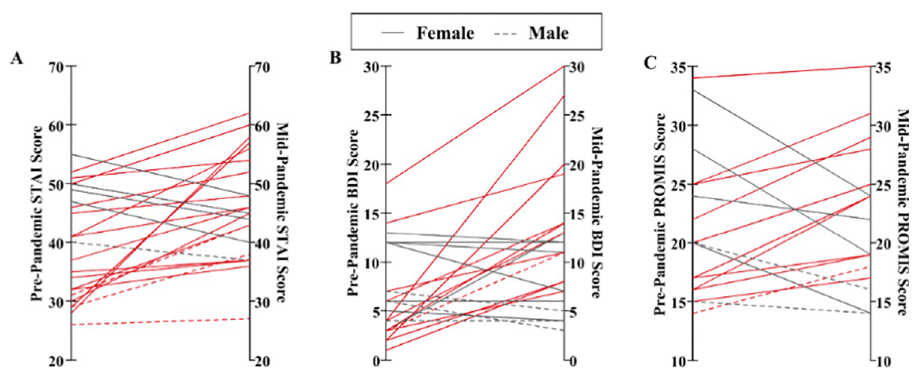
Fig 2. State Trait Anxiety Inventory (STAI) and BDI scores differ pre- and mid-pandemic. A) . STAI scores increased from pre- to mid-pandemic, (t (21) = -3.077, p = 0.006), with individuals being 4 times more likely to be anxious during mid-pandemic than during pre-pandemic (OR = 4.08, 95% CI: 1.11–15.02, Z = 2.12, p = 0.034). B) BDI scores increased from pre- to mid-pandemic (Z = -2.702, p = 0.007).